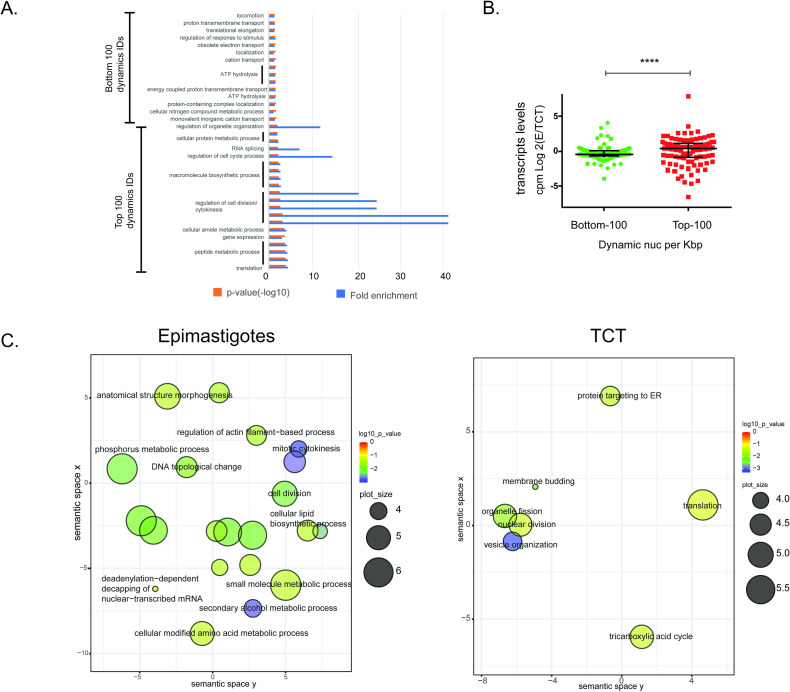
A. Biological process GO terms for the 100 most and least dynamic IDs (“top” and “bottom”, ranked by number of dynamic nucleosomes per kbp). Fold enrichment and -log10 of p-values are shown. B. Scatter plot comparing the log2 epimastigotes/TCTs CPM (counts per million) from Li et al [38] transcriptome data for the 100 top and bottom IDs as described in A. Statistical significance was obtained by F-test (p < 0.0001) and Mann-Whitney test (p-value = 0.0018). C. IDs that are enriched at fuzziness and/or occupancy specifically, at epimastigote or TCT forms—2016 (left) and 863 (right), respectively—were searched for GO/REVIGO functional annotations using TriTrypDB tools. The scatterplot shows a clusterization of GO terms (remaining after a redundancy reduction) in a two-dimensional semantic space, resulting in similar terms being plotted next to each other according to [75]. In general, more semantically similar GO terms are closer in the plot.